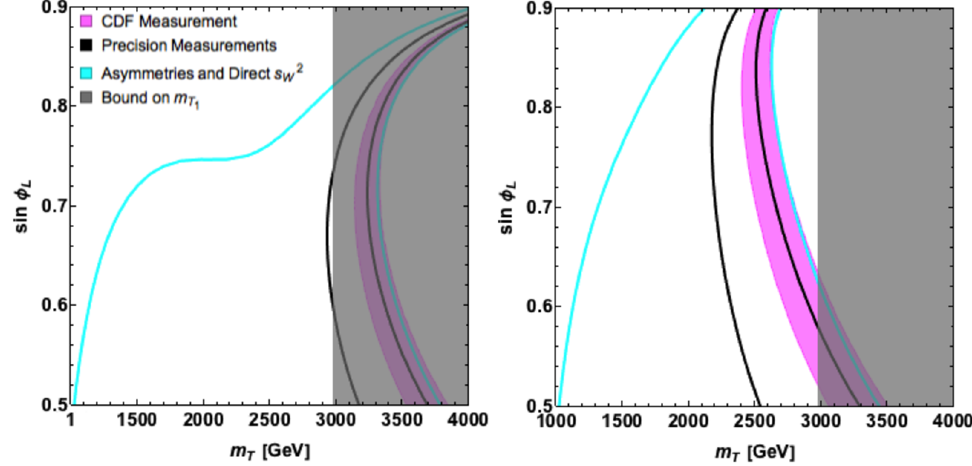
Figure 4 . Comparison of the new CDF measurement of the W mass (magenta band) to the m T - sin φ L parameter space of the SO (5) / SO (4) CH model for s θ = 0 . 2 , including the S and T contri- butions from both the fermion resonance singlet and fourplet. Between the black lines the precision measurements are fulfilled, while the cyan lines indicate the bound stemming from asymmetries and direct s 2 determination. All bounds are shown at 2 σ confidence level and for m V,A = 3 TeV, g = 3 e W and r = 0 . 8 . The coupling y R is determined up to a twofold ambiguity, where the bands in the m T - sin φ L parameter space are shown for the smallest (largest) y R solution in the left (right) panel. & 1 . 3 TeV from CMS and ATLAS The gray regions are excluded by the lower bound on m T 1